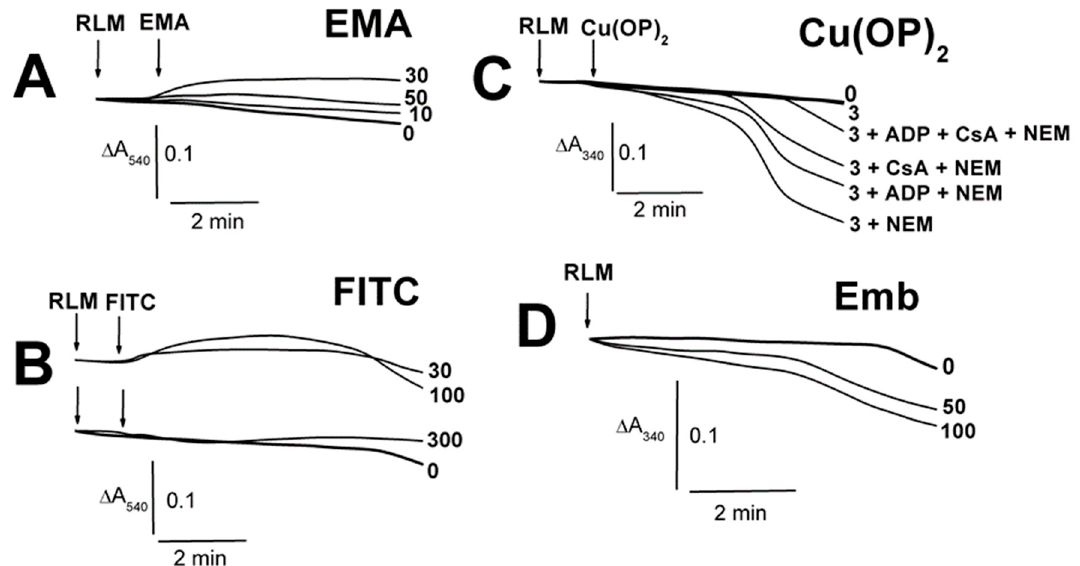
Figure 1. The influence of EMA, FITC, Emb, and Cu(OP) 2 on the swelling of succinate-energized rat liver mitochondria. Mitochondria (1.5 mg of protein per mL) were added into the medium A containing 5 mM Tris-succinate (pH 7.3) and 75 mM TlNO 3 , as well as 50–100 µ M Emb ( D ). Additions of mitochondria (RLM) and thiol-modifying agents (EMA, FITC, Cu(OP) 2 ) are shown by arrows. The numbers on the right of the traces show concentrations ( μ M) of EMA ( A ), FITC ( B ), and Cu(OP) 2 ( C ), as well as Emb ( D ), which was alone injected into the medium before mitochondria. In addition ( C ), 500 μ M ADP (ADP), 1 μ M CsA (CsA), and 50 μ M NEM (NEM) were added into the medium before mitochondria (where indicated). For more details on the media composition in Figures 1–7, see Section 4.